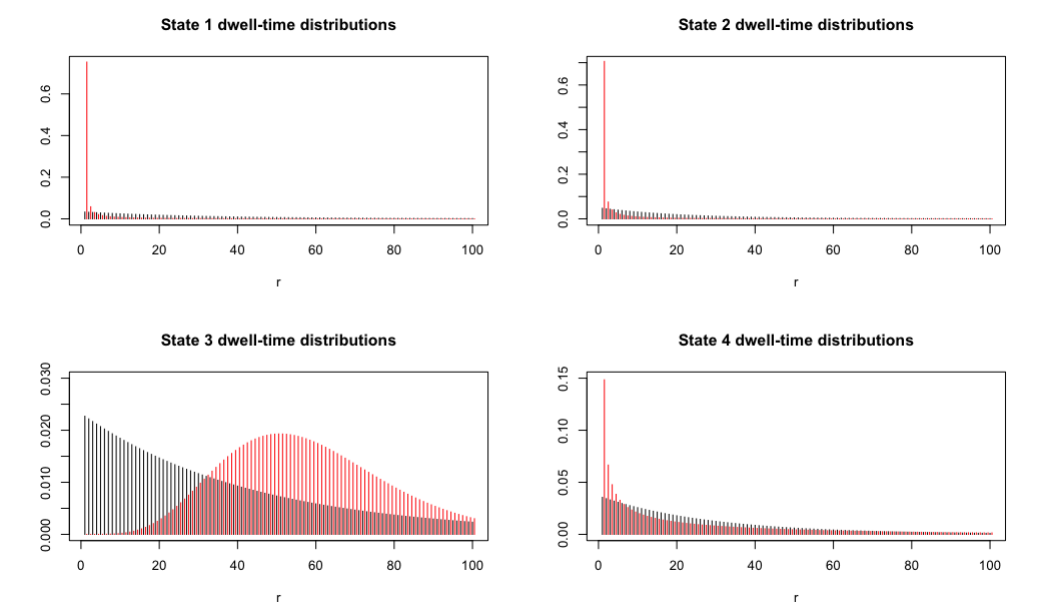
Figure 10. State dwell-time distributions for the homogeneous four-state normal HSMM (red) and for the stationary four-state normal HMM (black). Figure reproduced from